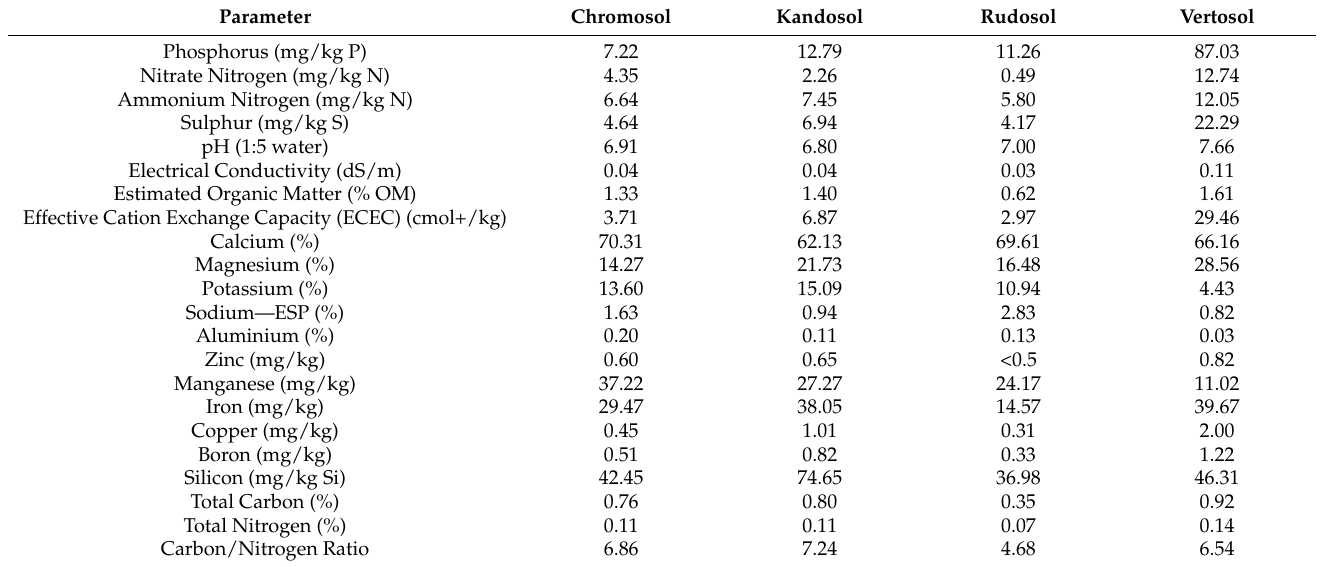
Table 1. Initial chemical properties of bulked soil types representative of four soils collected from 0–45 cm depths and bulked by field coring at each collection site, prior to column assembly.